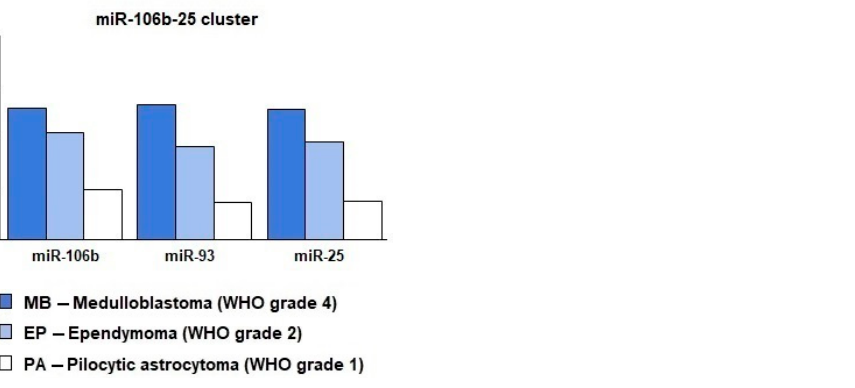
Figure 2. Relative expression level of members of three paralogical clusters in medulloblastoma, ependymoma, and pilocytic astrocytoma. ( A ) miR-17-92 cluster; ( B ) miR-106a-363 cluster; ( C ) miR-106b-25 cluster. Relative expression is given in ddCt value.